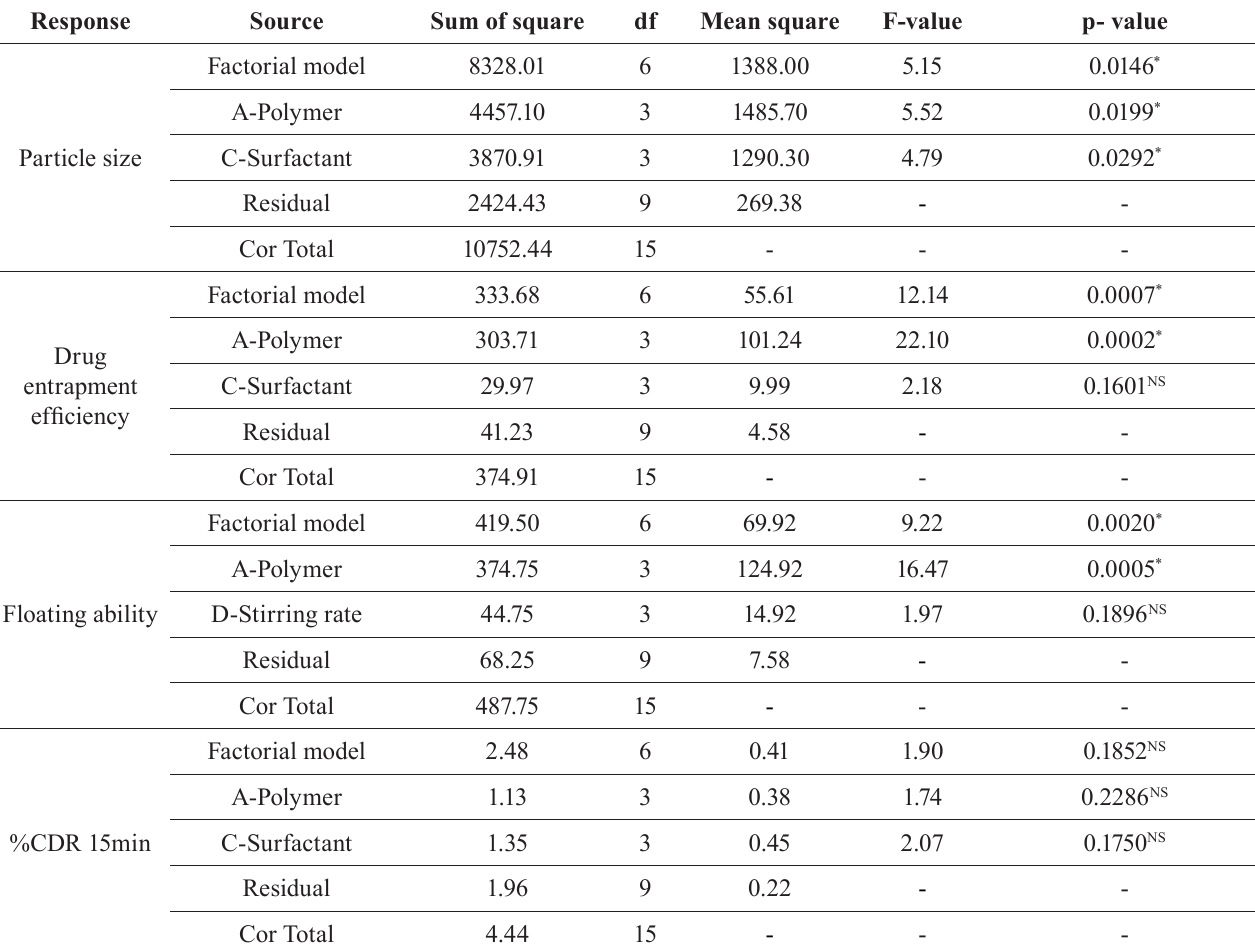
TABLE V - R esults of ANOVA